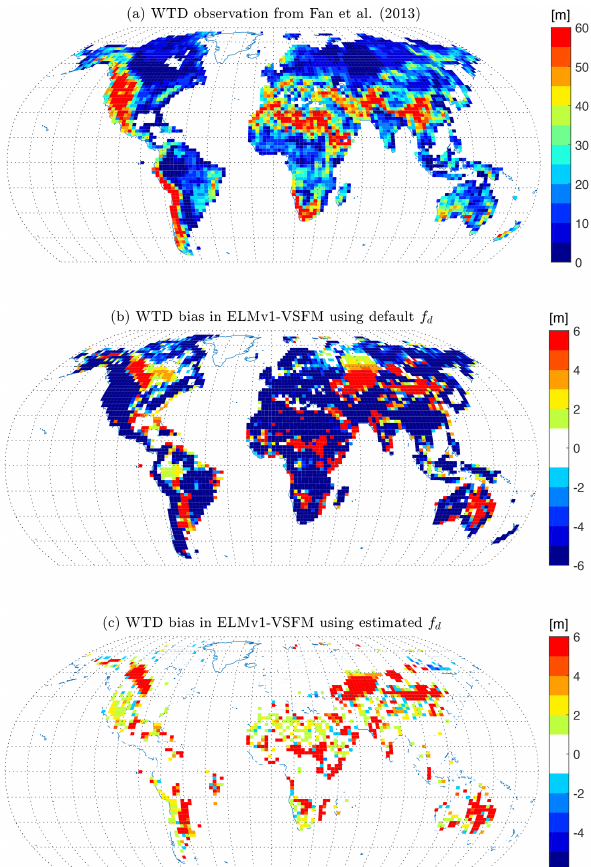
Figure 6. (a) Water table depth observation from Fan et al. (2013); (b) water table depth biases ( = Model–Obs) from ELMv1-VSFM using default spatially homogeneous f d ; and (c) water table depth biases from ELMv1-VSFM using spatially heterogeneous f d .